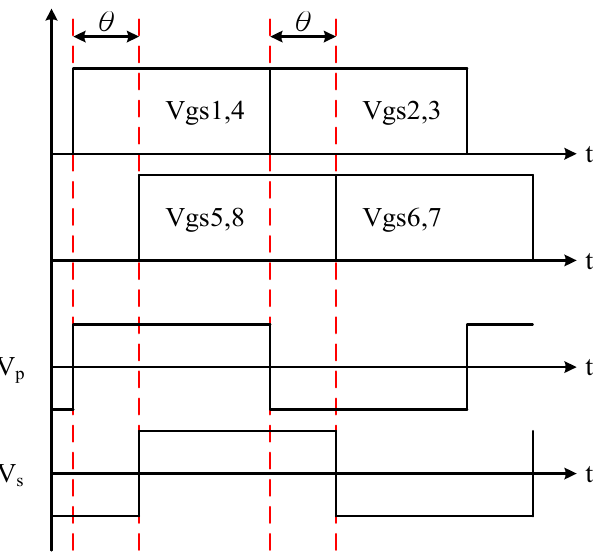
Figure 2. Control waveforms of SPS control. When the control signal of the full-bridge rectifier on the primary side of the trans- former is ahead of the control signal of the full-bridge rectifier on the secondary side of the transformer, the energy is transferred from the DC bus to the energy storage (battery pack). Conversely, when the control signal of the full-bridge rectifier on the secondary